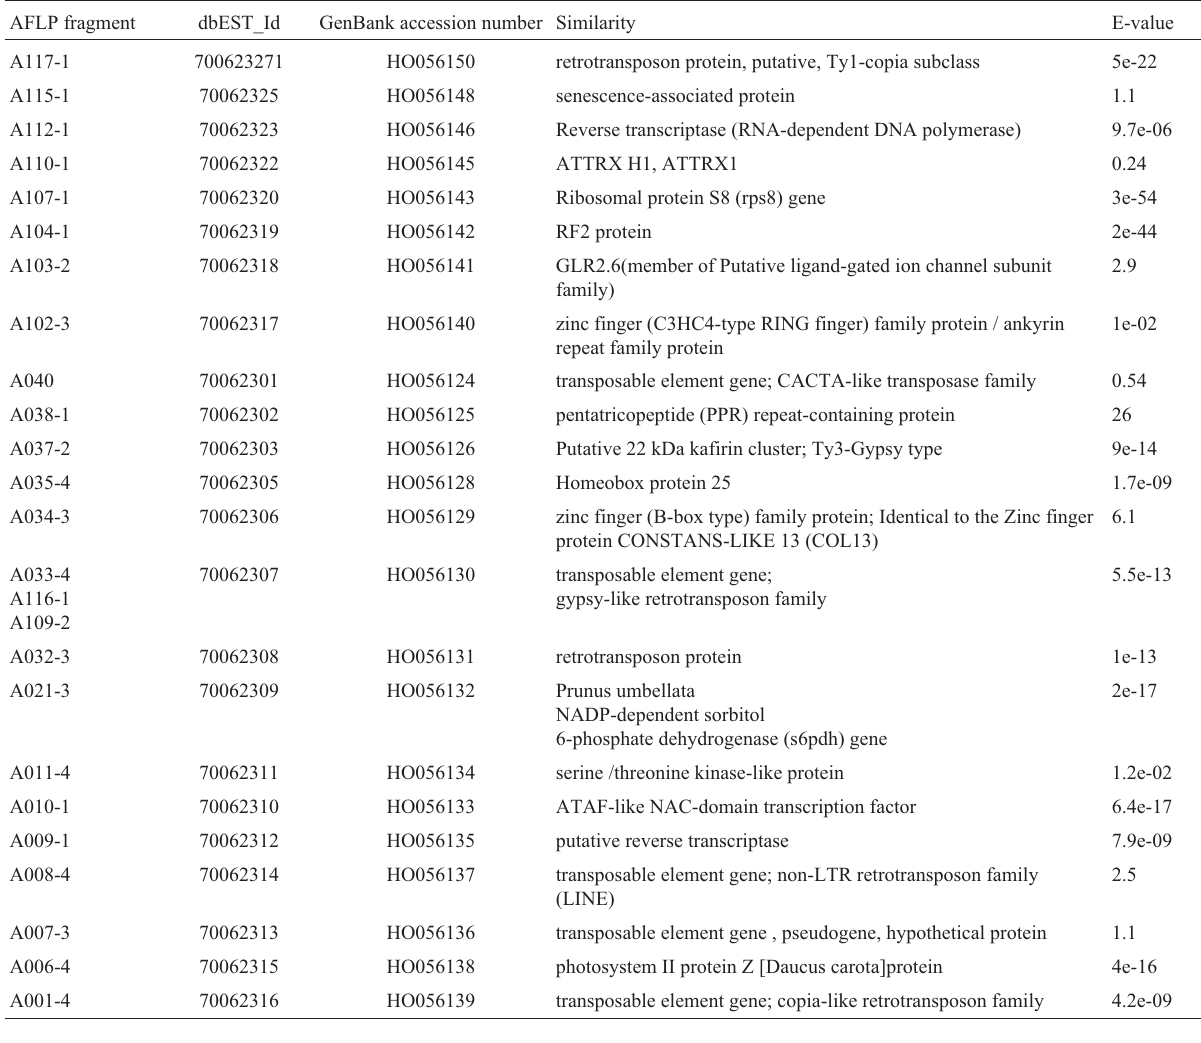
Table 1 - Nucleotide homology of the transcript derived fragments (TDFs) with known gene sequences in non-redundant public databases. Shown are BLASTN results along with their respective similarity values.